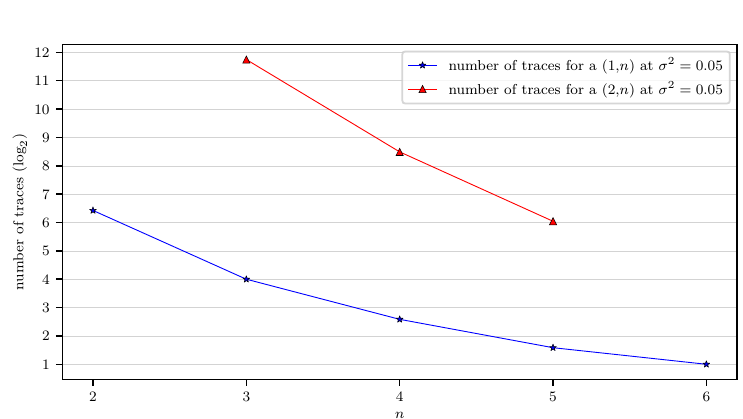
Figure 1: Number of traces needed by ML distinguisher to reach 90% success rate in the noisy Hamming weight model with σ 2 = 0 . 05 against redundant ( d, n ) polynomial masking schemes with d = 1 and d = 2 for varying n